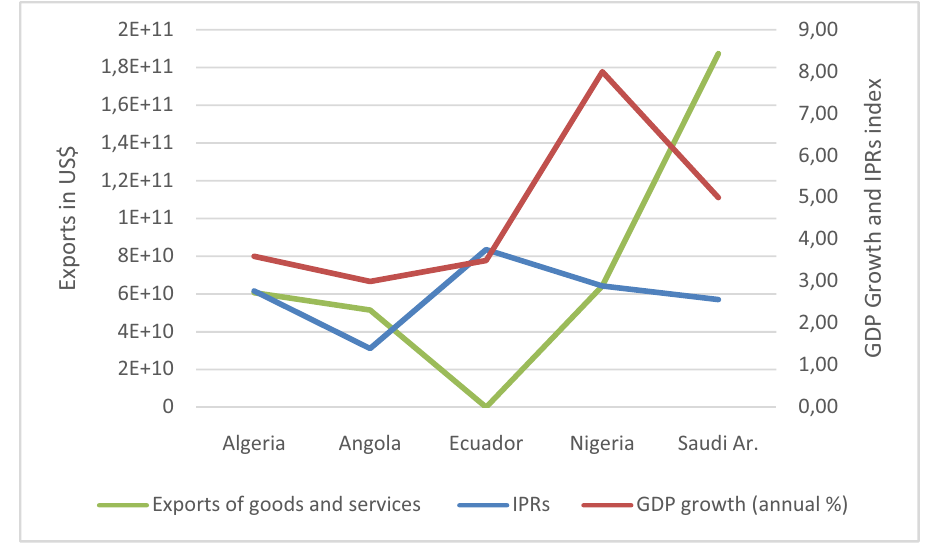
Fig. 1. Relationship between some of the key macroeconomic indicators and IPRs for selected OPEC members in